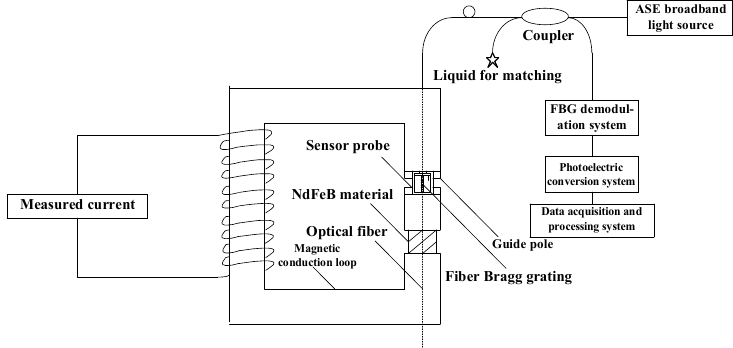
Figure 4. The overall structure of the sensitivity-enhanced fiber grating current sensor. The magnetic conduction loop is constructed of ferrite material. The sensing system is composed of a magnetic circuit system established by a magnetically conductive material and a guide pole. The NdFeB material provides the required bias magnetic field. An ASE broadband light source is used as the incident source in this sensor. The coupling ratio of the coupler is